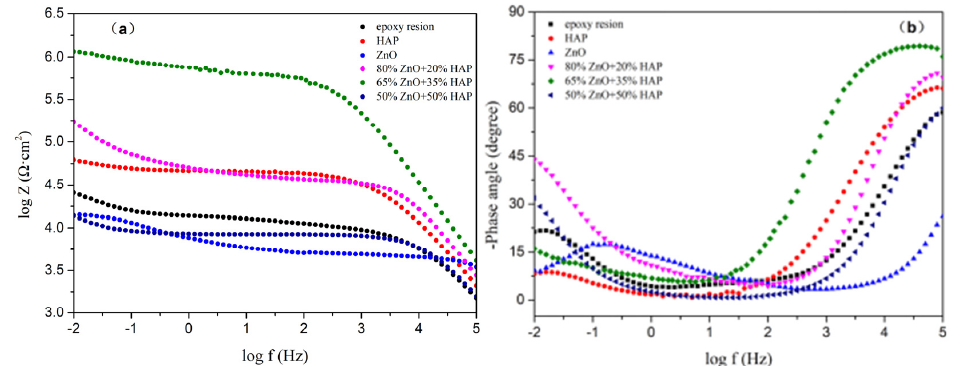
Figure 11. Bode plots of different electrodes soaked for 24 h: ( a ) impedance modulus spectrum and